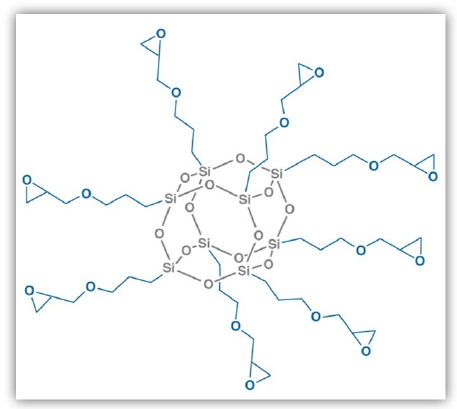
Figure 1. Chemical structure of GPOSS .